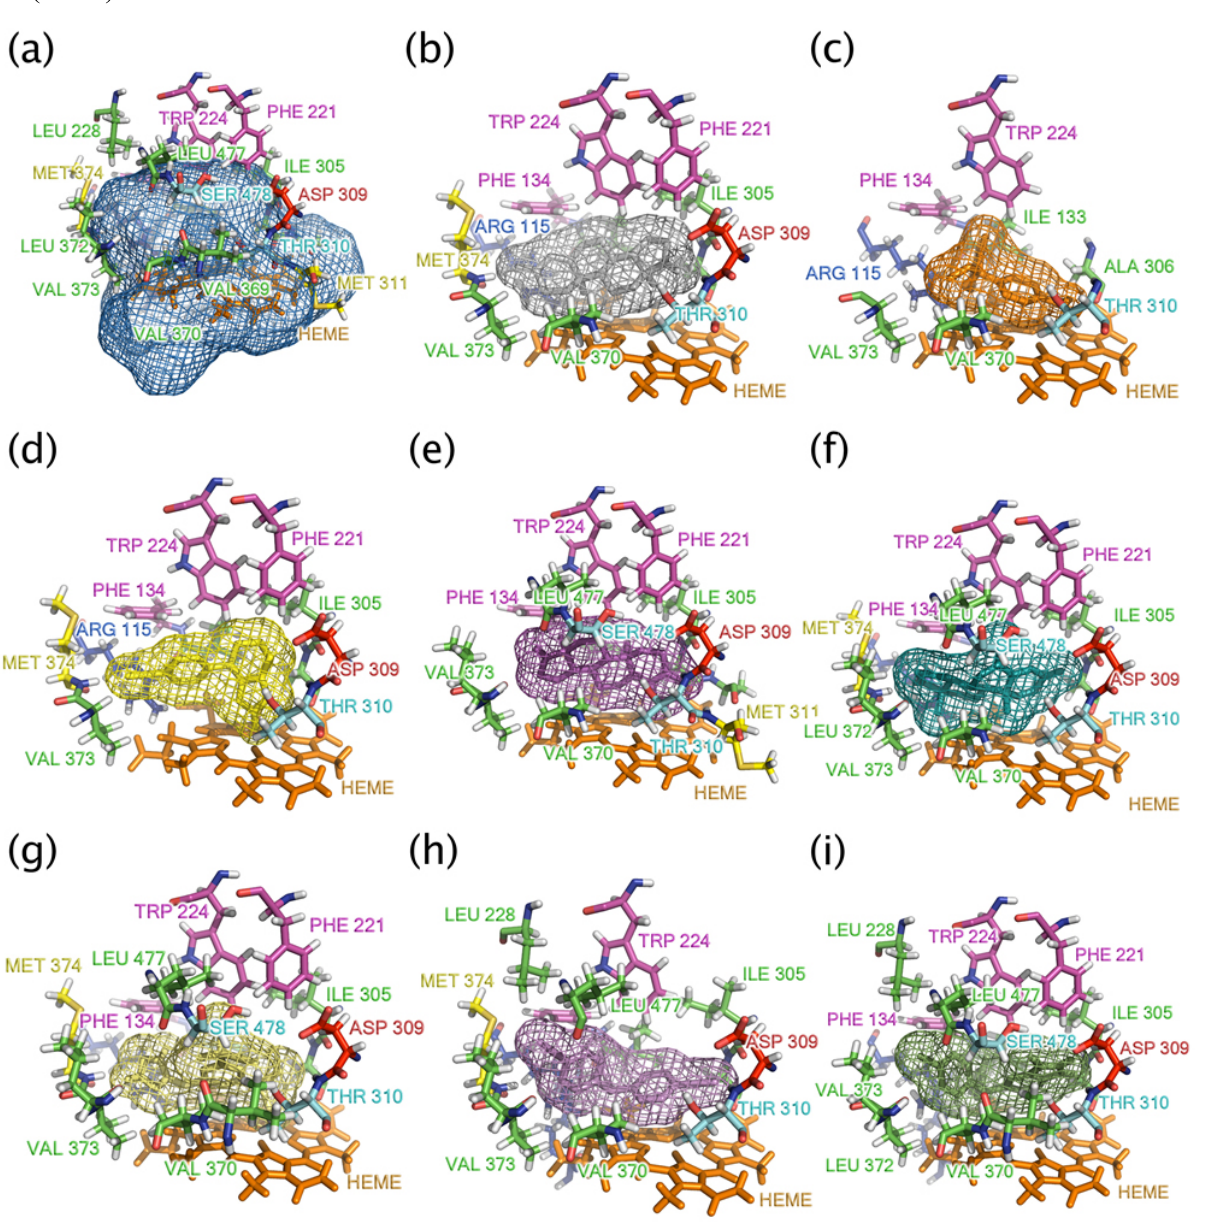
Figure 6. (a) The binding site of aromatase, represented as a mesh, is shown interacting with its natural substrate (b) androstenedione the following aromatase inhibitors (c) aminoglutethimide, (d) fadrozole, (e) formestane, (f) exemestane, (g) anastrozole, (h) letrozole and (i) vorozole. Environmental residues within a radius of 4 Å around the ligands are color-coded according to its molecular property as shown in green (non-polar), purple (aromatic), red (negatively-charged), cyan (polar), yellow (methionine) and orange